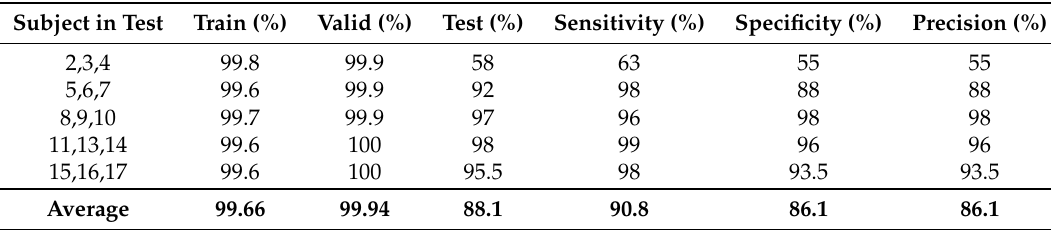
Table 7. The accuracy measures for the generic models with 20% calibration samples using spatial domain images.